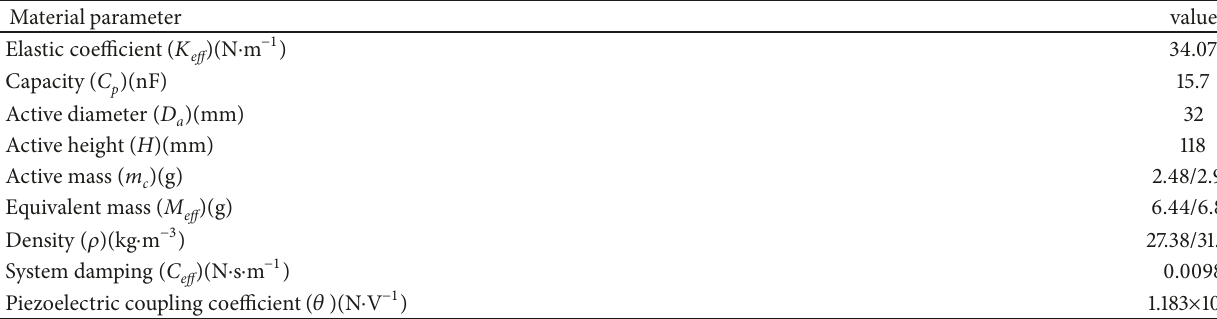
Table 3: Material parameters involved in the